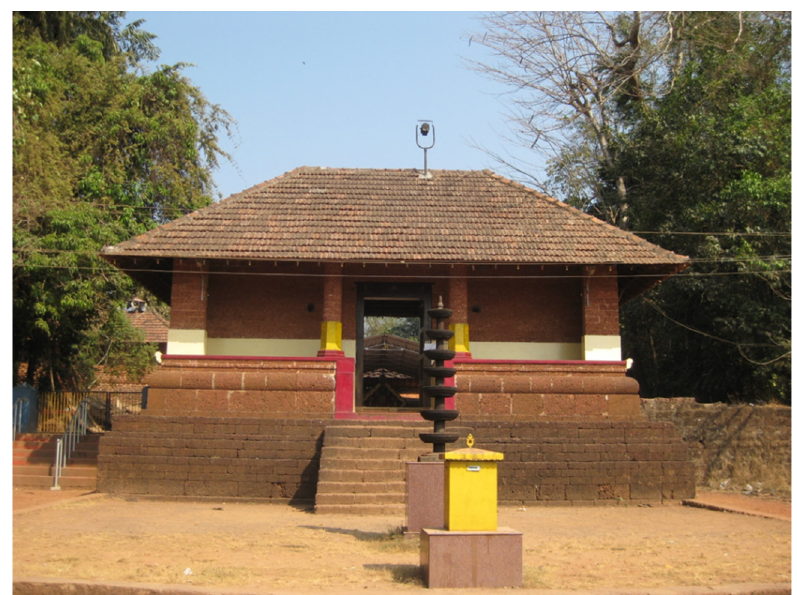
Figure 1. Ka ḷ ariv ā tukkal, a Śā kta temple of the Pi ṭ ā rars. Photo by Maciej Karasinski-Sroka. Figure 1. Kal.ariv¯atukkal, a ´S¯akta temple of the Pit.¯arars. Photo by Maciej